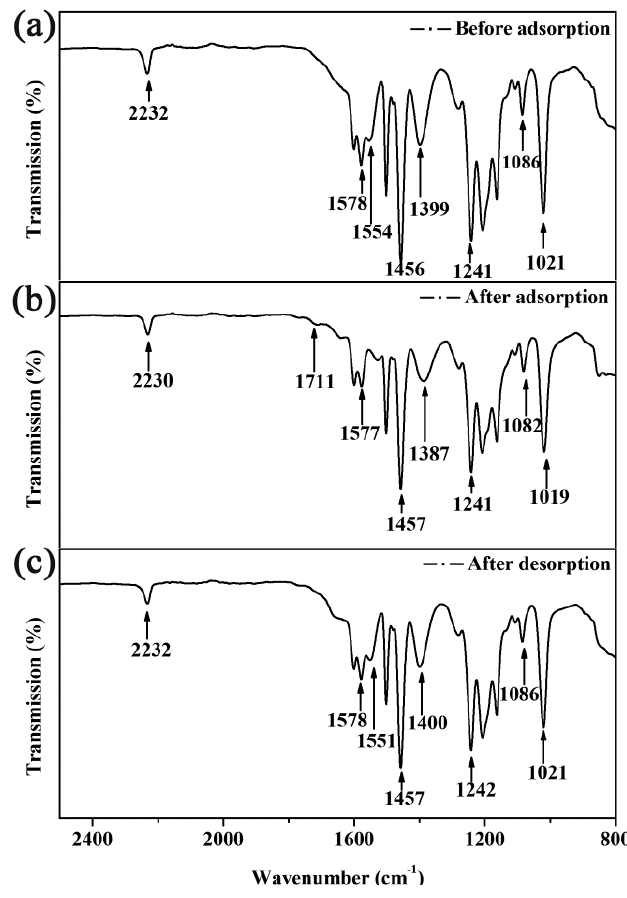
Figure 9. ATR-FTIR of SPEN-CTAB-0% before and after adsorption and desorption.